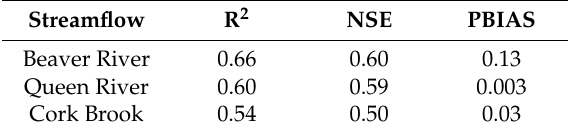
Table 2. Statistical results of daily streamflow validation produced by SWAT-CUP.